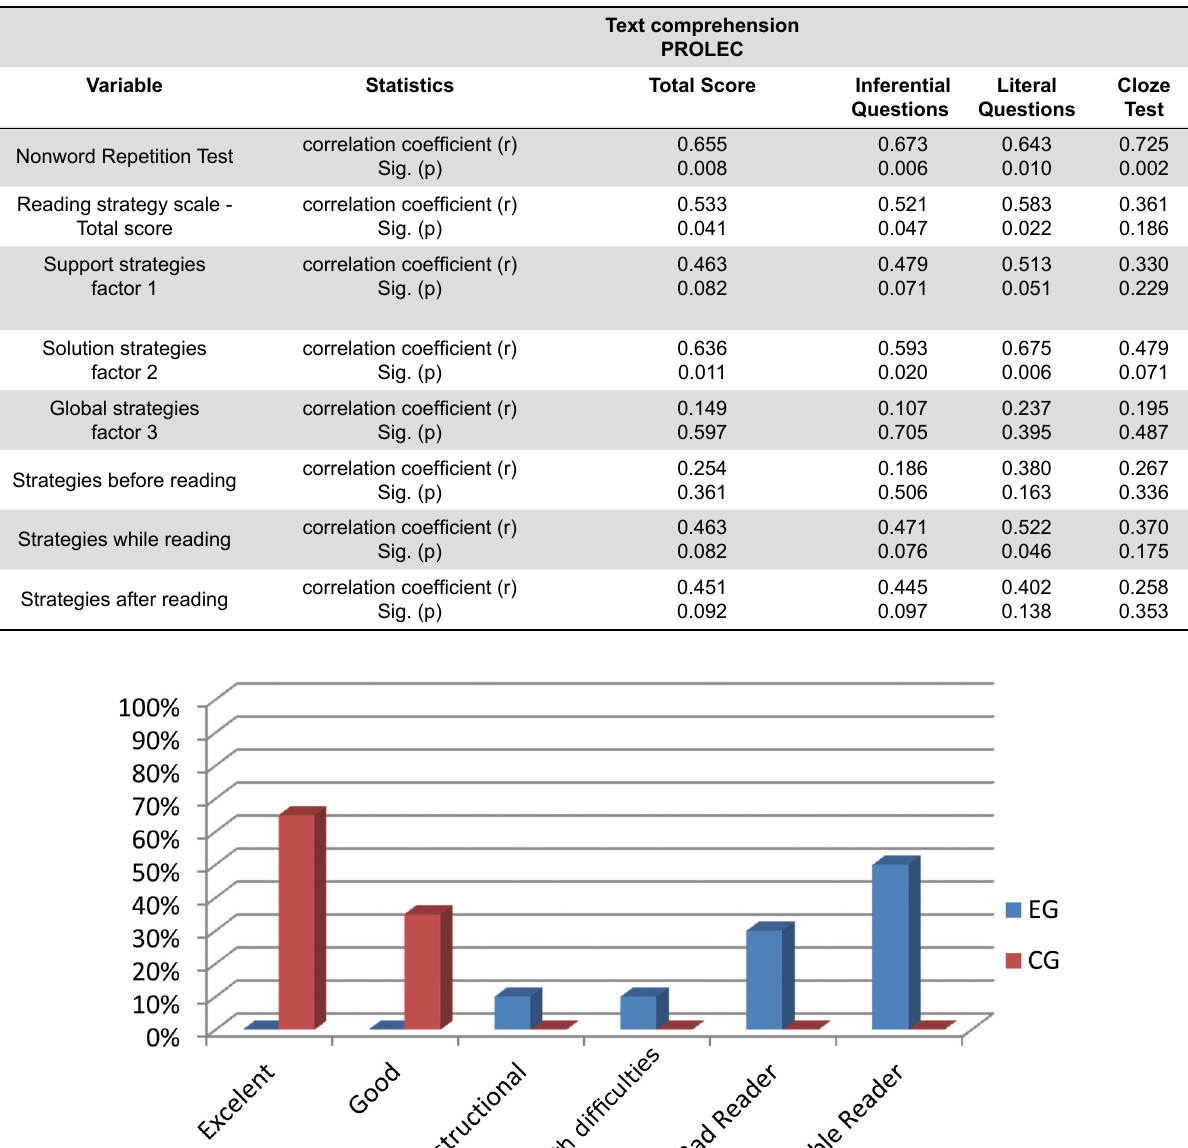
Table 2- Spearman correlation analysis between the experimental groups (EG) evaluated skills and reading comprehension tests